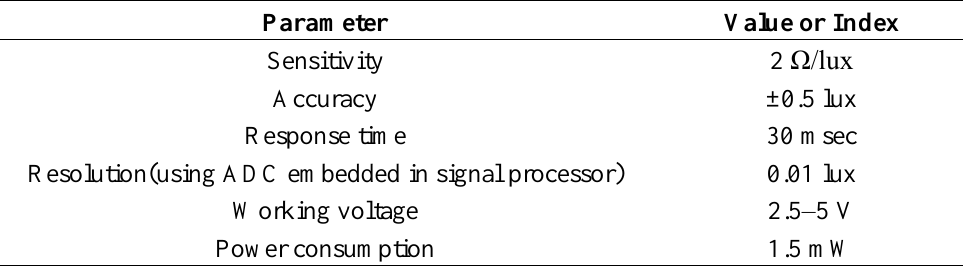
Table 4. Parameter list of the optical sensor